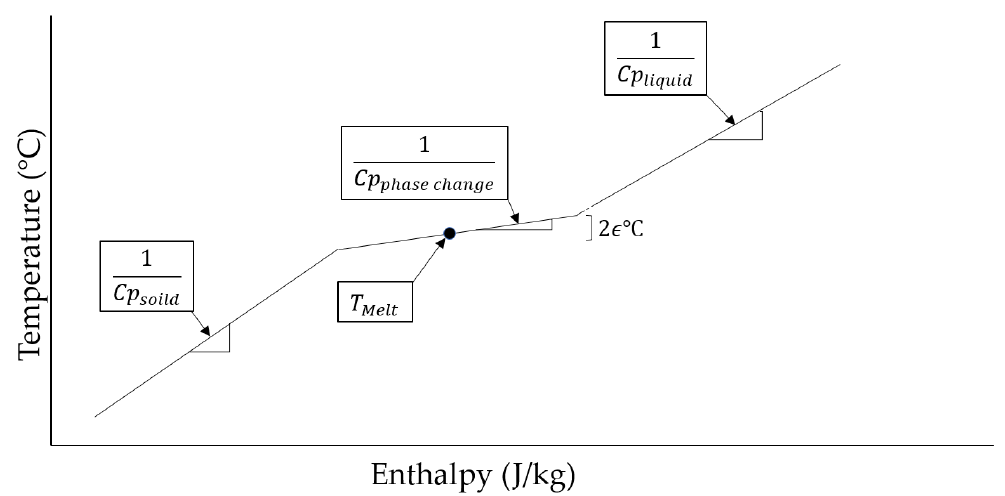
Figure 3. Numerical Approximation of Specific Heat for Phase Change Materials (PCM).